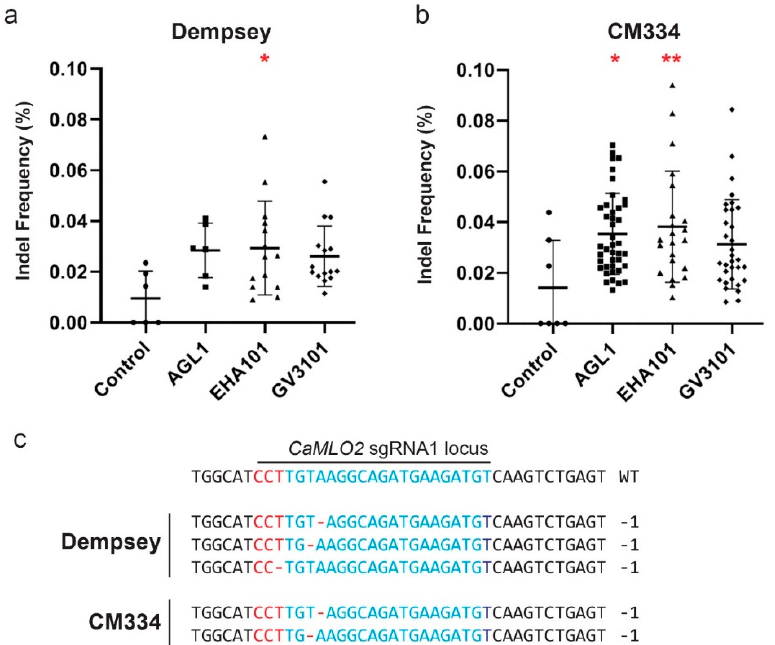
Figure 5. Comparison of indel frequencies of selected pepper calli following Agrobacterium -mediated